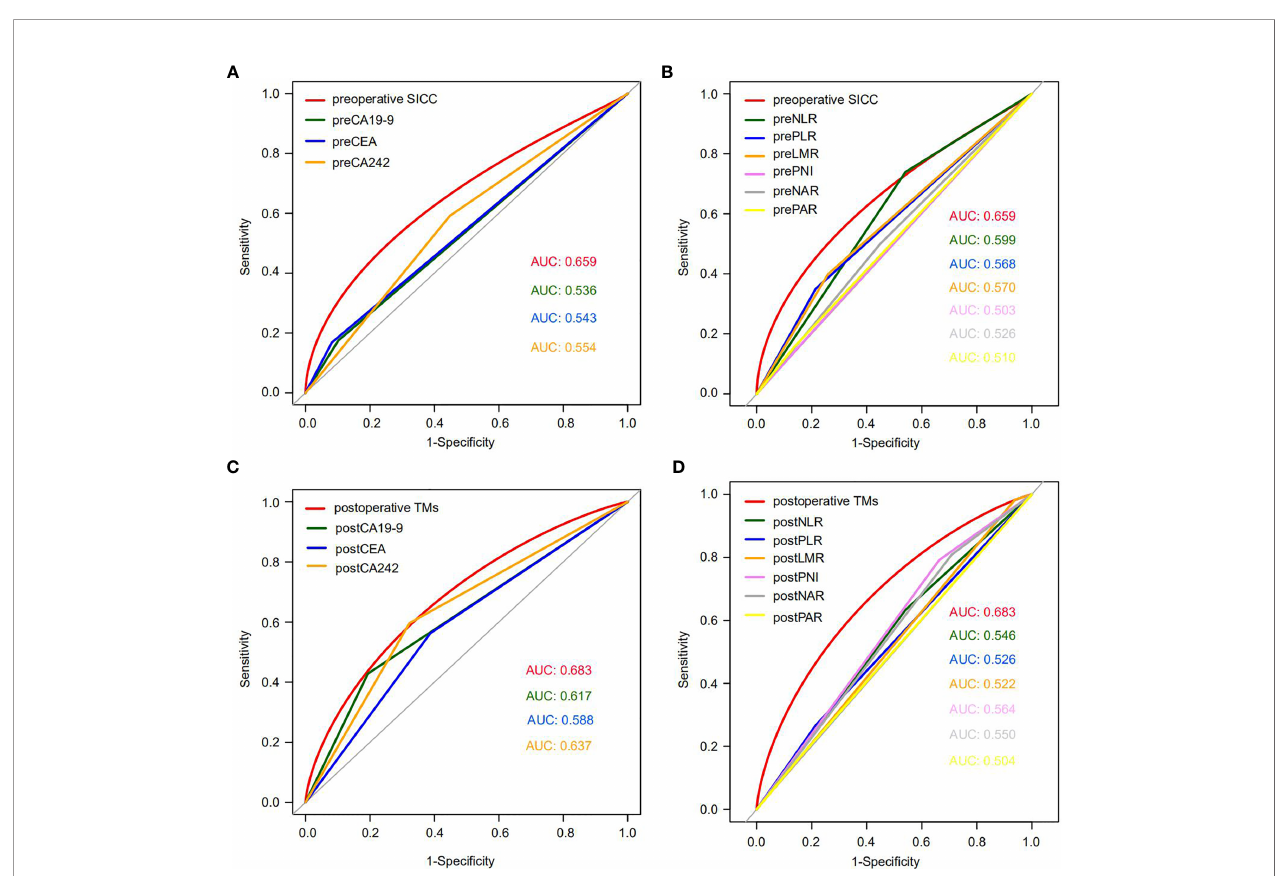
FIGURE 2 | The ROC curves of preoperative SICC, postoperative TMs, tumor markers and six combinations of in fl ammatory factors in the training cohort. (A) Comparison of the ROC curves for early recurrence between preoperative SICC and preoperative tumor markers for PDAC patients who underwent radical resection. (B) Comparison of the ROC curves for early recurrence between preoperative SICC and preoperative six combinations of in fl ammatory markers. (C) Comparison of the ROC curves for early recurrence between postoperative TMs and postoperative tumor markers. (D) Comparison of the ROC curves for early recurrence between postoperative TMs and postoperative six combinations of in fl ammatory